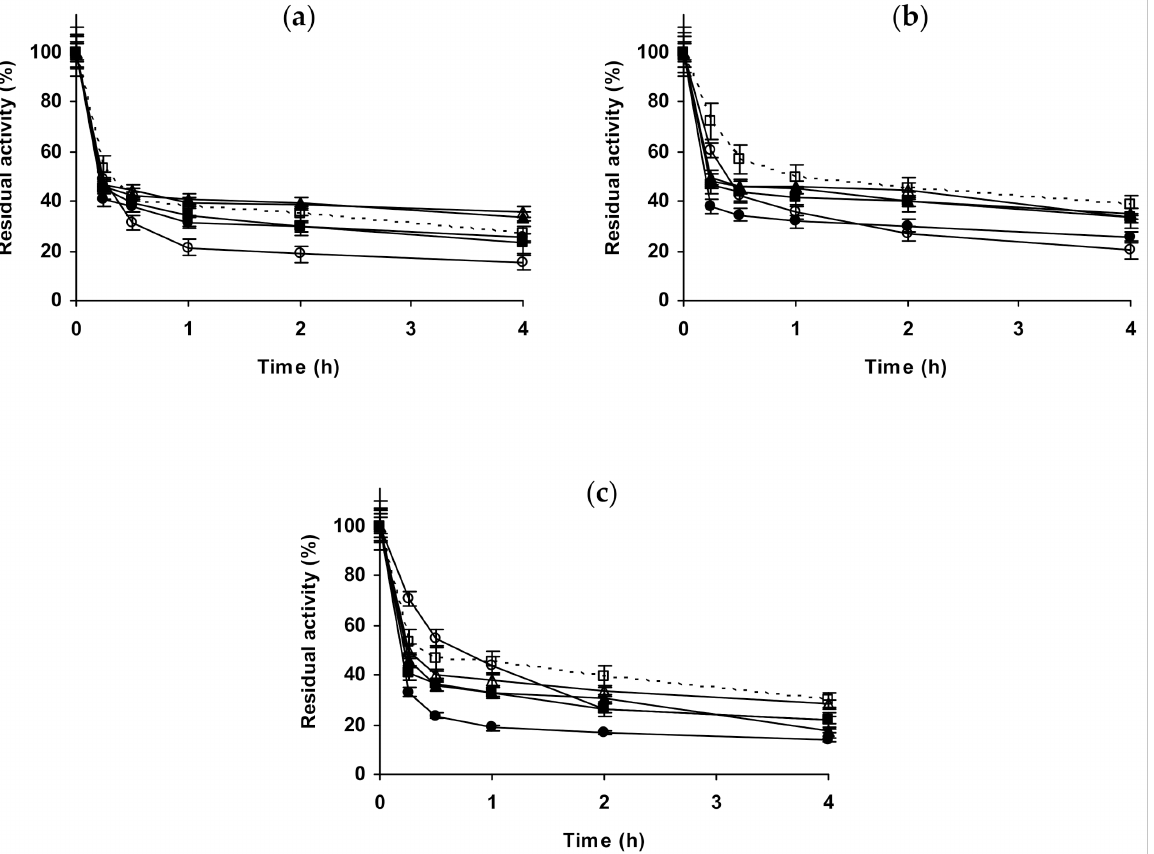
Figure 11. Effect of ionic strength and inactivation pH on the stability of glyoxyl-PGA. ( a ) pH 5.0 and 65 ◦ C; ( b ) pH 7.0 and 65 ◦ C; ( c ) pH 9.0 and 47 ◦ C. Other specifications are described in the Methods section. Dotted line, empty squares: references; full triangles: 1 M NaCl; empty triangles: 3 M NaCl; full circles: 1 M (NH 4 ) 2 SO 4 ; empty circles: 3 M (NH 4 ) 2 SO 4 and full squares: 1 M Na 2 SO 4